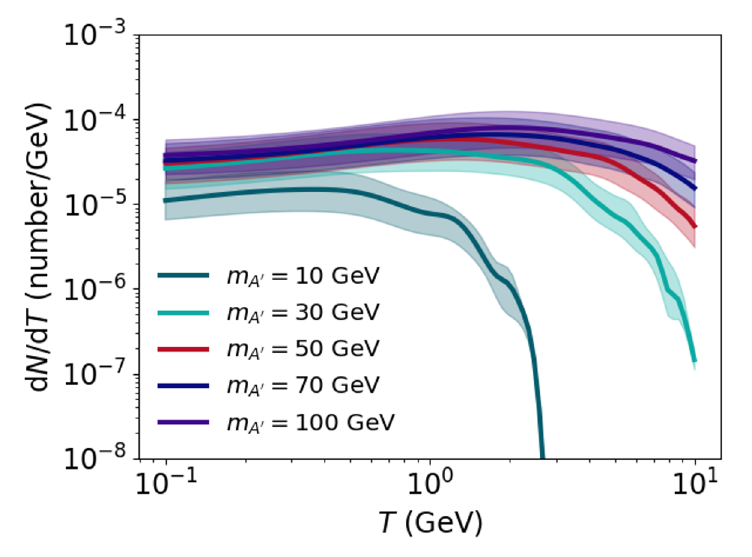
Figure 4. Injection spectra obtained with Pythia 8 for various choices of dark photon mass m A 0 . The shaded region shows a range of coalescence momenta p 0 = 150 (cid:6) 25 MeV; the wiggles in the spectra are numerical artifacts. Figure 5. Similar to (cid:12)gure 4, but isotropically boosted to the dark matter (halo) rest frame assuming m (cid:31) = 2 m 0 . A { 7